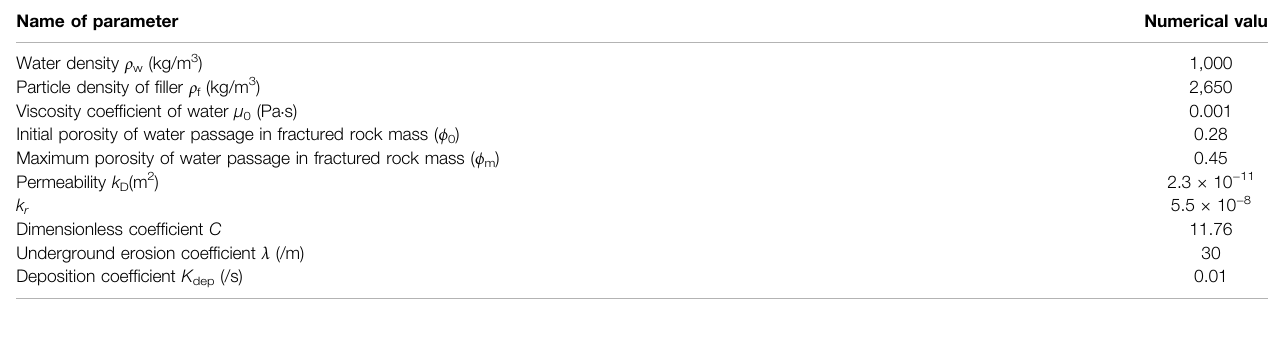
TABLE 2 | Hydrodynamic parameters employed for numerical calculations.